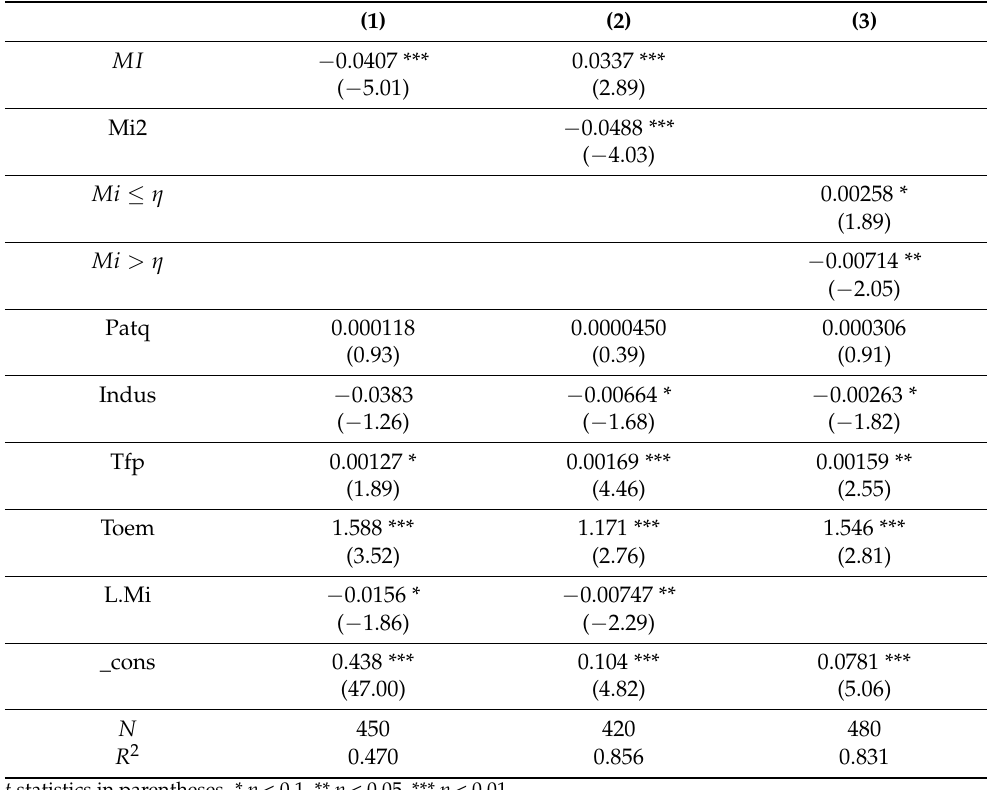
Table 3. Double-faced effect